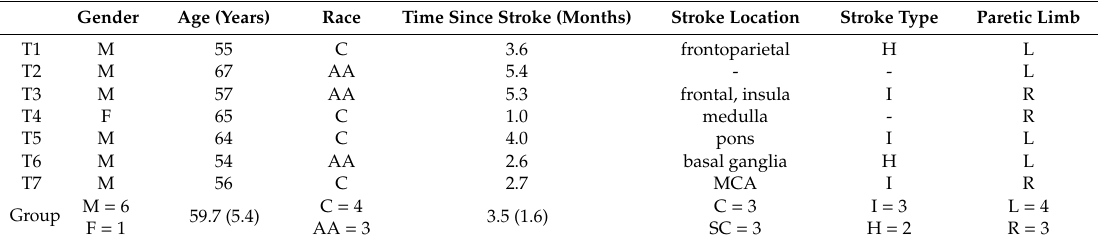
Table 1. Participant demographics. Individual and group average data are shown. For categorical variables, group data shows count in each category; for continuous variables, values are mean (standard deviation). Short dashes represent data that was unavailable from patient records. M: male; F: female; C: Caucasian; AA: African American; MCA: middle cerebral artery; C: cortical; SC: subcortical; I: ischemic; H: hemorrhagic; L: left; R: